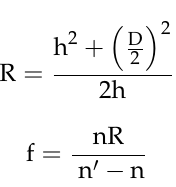
Figure 4. Designed and prepared convex microlenses with diameter and height of 40 µ m and 10 µ m. ( a – c ) are their SEM image, 3D morphology and section profile, respectively. ( d , e ) are imaging and focusing performance demonstrations. In addition, our proposed method of wet etching-assisted FsLDW can be used to prepare convex microlenses with high surface quality and high surface quality concave microlenses. As shown in the LSCM image in Figure 5a, a concave microlens with high surface smoothness was fabricated on glass. Figure 5b and c show the three-dimensional morphology and cross-sectional profile, respectively. The red line in Figure 5c exhibits the fitted line of the cross-section profile of the concave microlens in Figure 5a. The fitted result indicates that the concave microlens has a spherical profile with a radius of curvature of 220 µ m. According to the principle of geometrical optics, the radius of curvature R and focal length f of the spherical microlens satisfy the following equations: